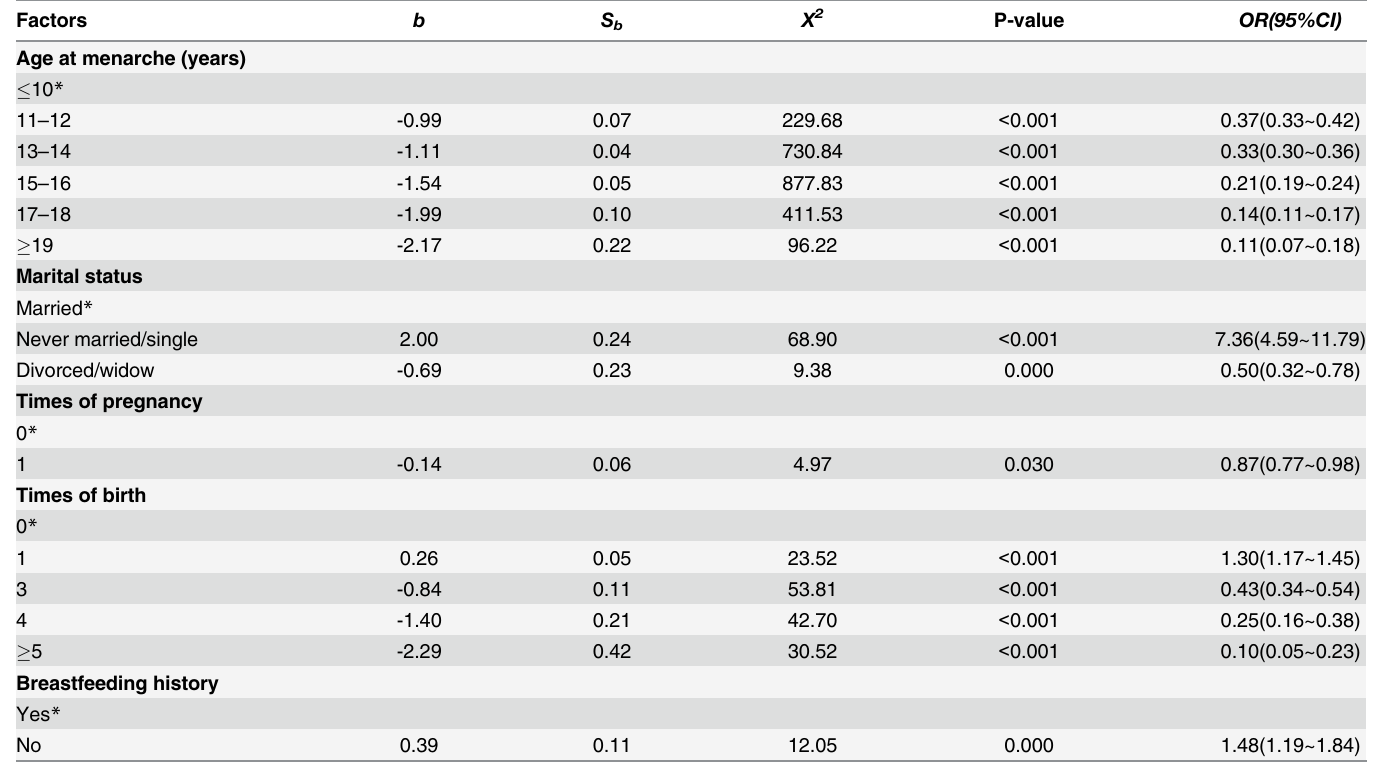
Table 4. Multivariate logistic regression analysis of “ young ( (cid:1) 40 years) ” age breast cancer-related risk factors among all breast cancer